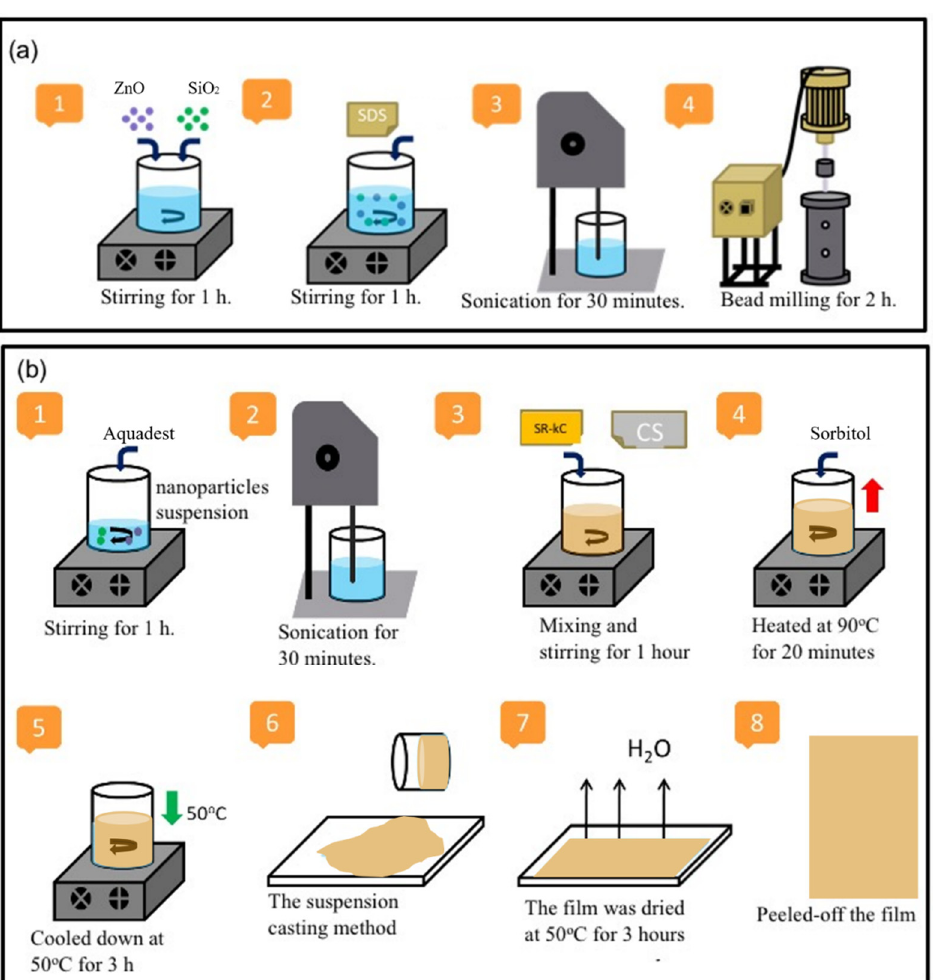
Figure 1. Schematic illustration of ( a ) preparation of ZnO − SiO 2 nanoparticle suspension; ( b ) incor- poration of CS at various concentrations into previously developed ZnO/SiO 2 − SR κ C bionanocom- posite film.